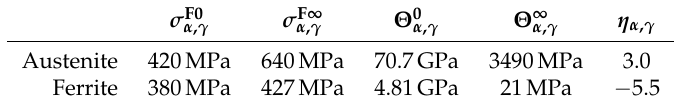
Table 3. Material parameters derived from measurements orthogonal to the rolling direction